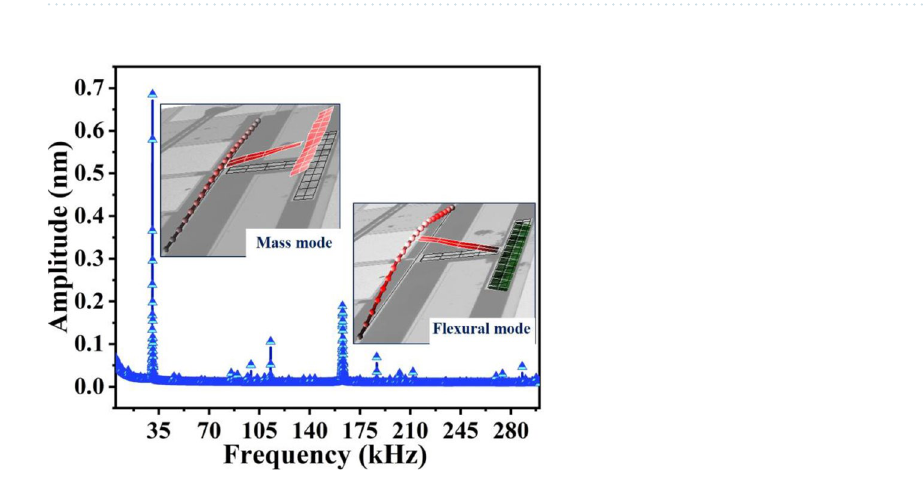
Figure 5. Frequency response due to white noise excitation with measured mode